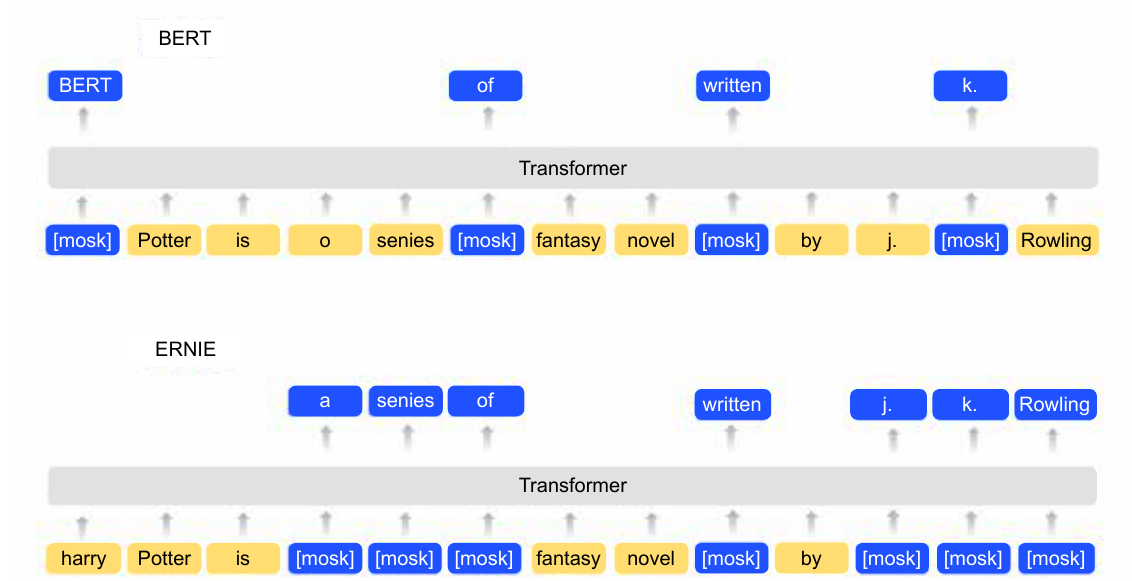
Figure 2 When covering up a prediction about Harry Potter, BERT masks single word, and ERNIE1.0 uses entity or phrase as a basic masking unit